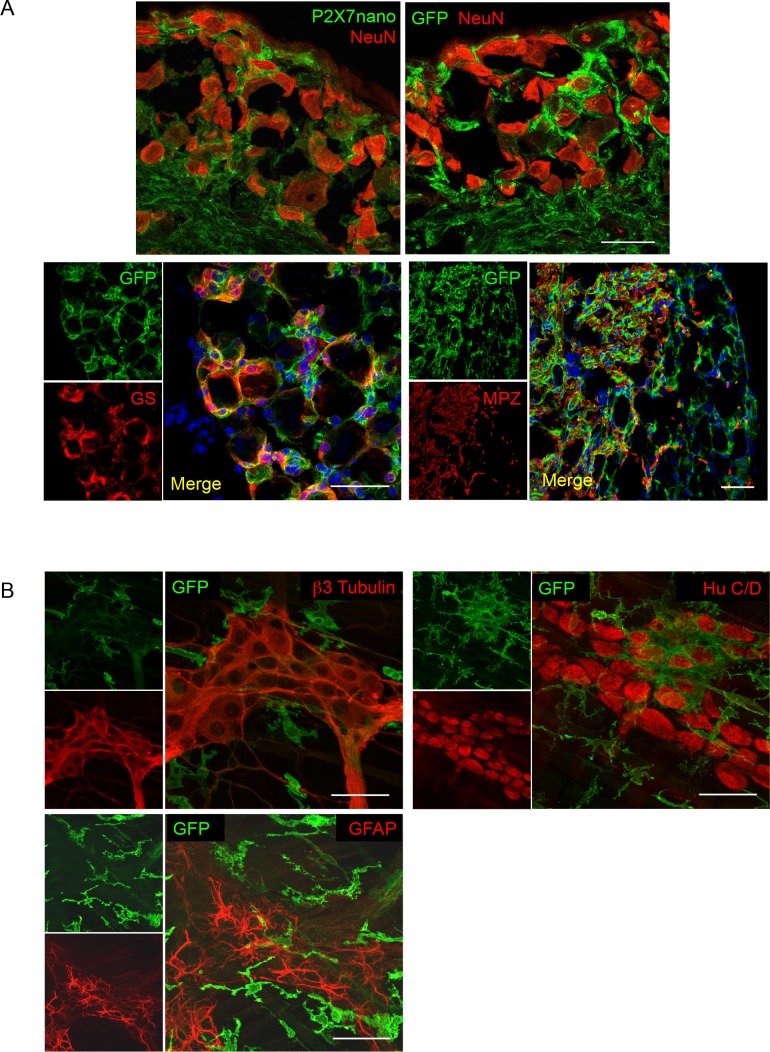
P2X7-EGFP localization in DRG and myenteric plexus preparations.(A) Upper panel Co-staining of anti-P2X7 nanobody-based antibody or anti-GFP antibody (ab6556, abcam) with NeuN in dorsal root ganglions of line 17 mice shows no localization of P2X7 -EGFP in NeuN positive cells. Lower panel A fraction of P2X7-EGFP positive cells represent glutamine synthetase-positive satellite glia cells that closely surround the neurons. P2X7-EGFP-positive cells are not labeled with the Schwann cell marker myelin protein zero (MPZ) but closely associate with MPZ-positive cells which are localized in a region with fewer sensory neuron cell bodies, but probably rich in nerve fibers. Scale bars: 50 μm, n > 3. (B) Upper panel No costaining of P2X7-EGFP (ab6556, Abcam) with the neuronal markers β3-tubulin and HuC/D in the myenteric plexus of the colon. Lower panel The glia marker GFAP (MAB360, Millipore) also does not co-localize with P2X7-EGFP. Scale bars: 25 μm, n > 3 animals.